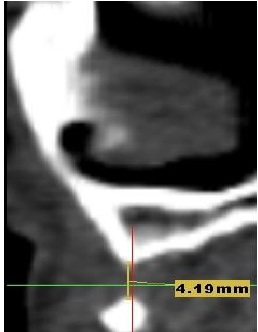
Figure 2. The CBCT aspect of the initial situation: the defect measures 4.19 mm in length and 4.2 mm in width of bone deficiency.